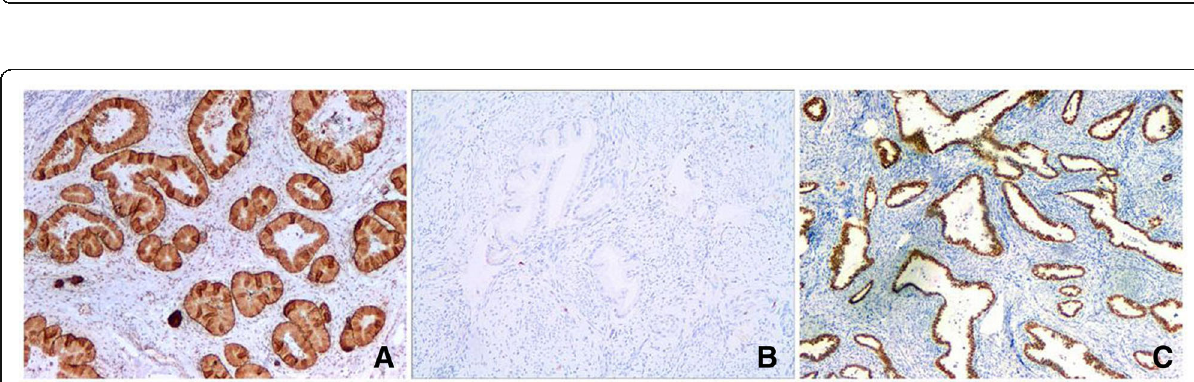
Fig. 2 a Gross feature of gastric-type adenocarcinoma (GAS). The cervix was partially or entirely replaced by a firm indurated mass imparting a barrel-shaped enlargement. b - c , Well-differentiated GAS showed haphazardly arranged and irregularly shaped neoplastic glands, which were usually associated with a desmoplastic stromal reaction. The cells showed voluminous, clear to foamy cytoplasm and distinct cellular borders (H&E, 100×). d Moderately or poorly differentiated GAS showed extensive epithelial proliferation with crowded, back-to-back glands (H&E, 40×). e A GAS showed an area with voluminous clear cytoplasm and round, markedly atypical nuclei (H&E, 100×). f Uniform mucinous cells showed minimal or no cytological atypia (H&E, 40×). g A GAS case showed mild to moderate nuclear enlargement and pseudostratification (H&E, 200×). h - i , Bland-appearing mucinous epithelium replaced the fallopian tube normal epithelium and was composed of columnar cells with basally located small nuclei, without distinct nuclear abnormalities (H&E, 100×,200×)